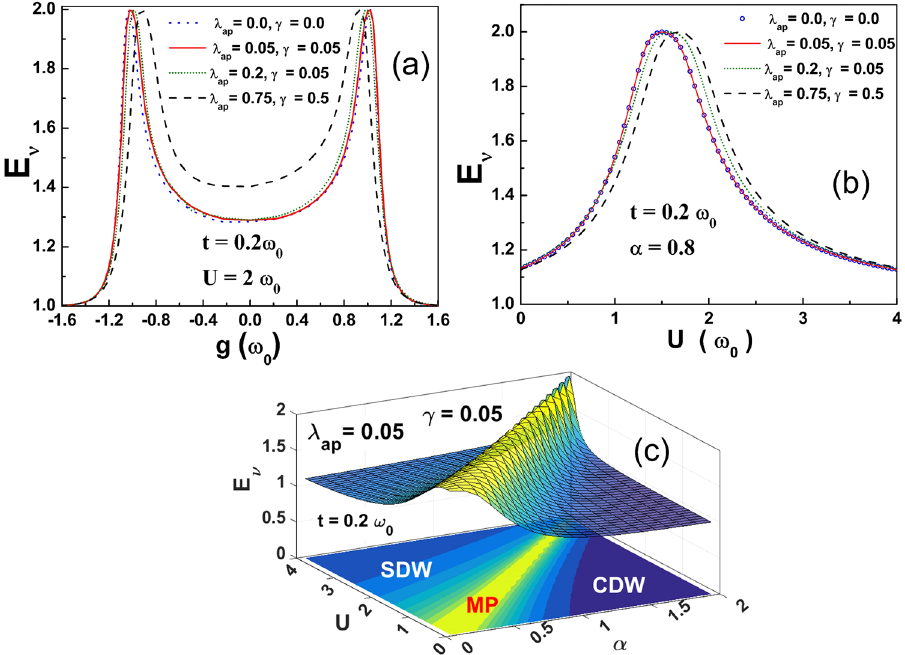
Figure 10. ( a ) Quantum Entanglement ( E ϑ ) as a function of g. ( b ) E ϑ as a function of U . ( c ) E ϑ on the α - U plane with its contour